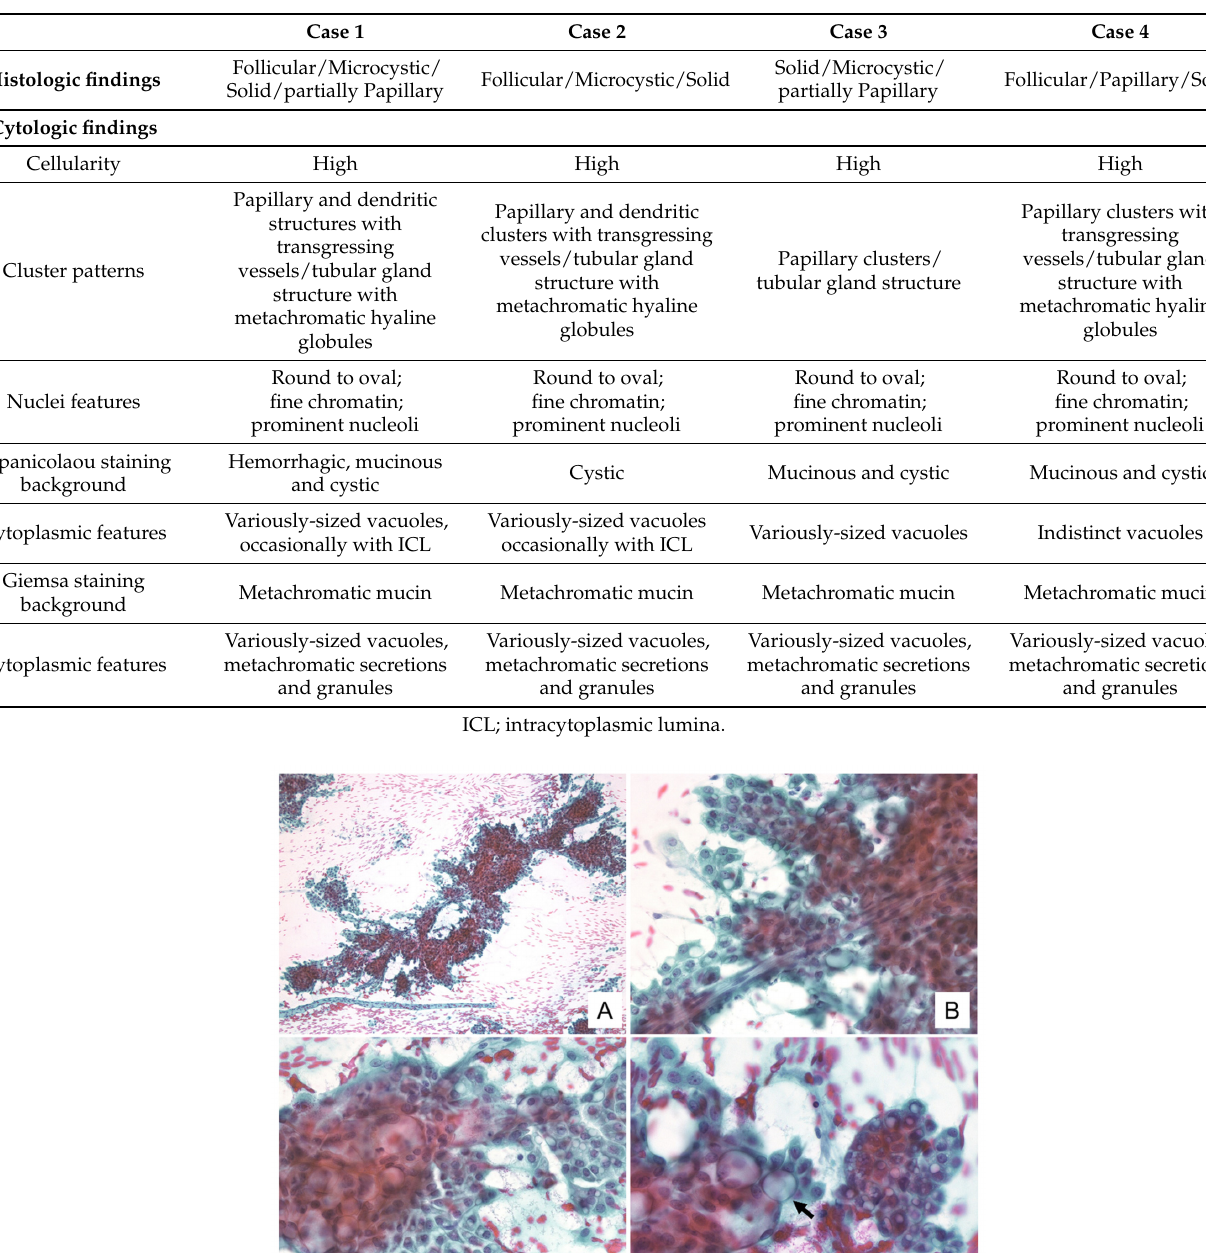
Table 2. Histological and cytological findings of secretory carcinoma.